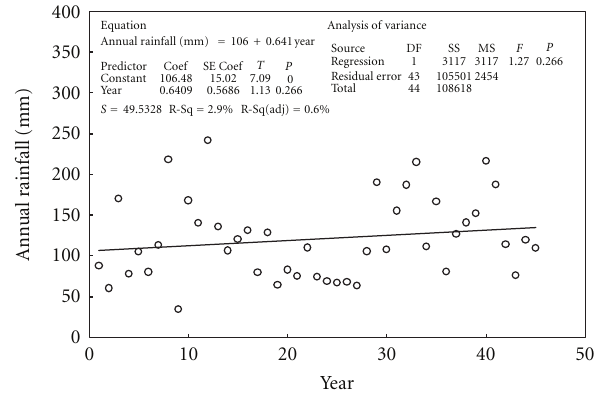
Figure 6: Annual total rainfall versus time for the data obtained from the weather station of Kuwait International Airport for the time duration from 1965 (corresponding to year number 1) to 2009 (year number 45). The solid line represents a trend fitted for the data using linear regression.